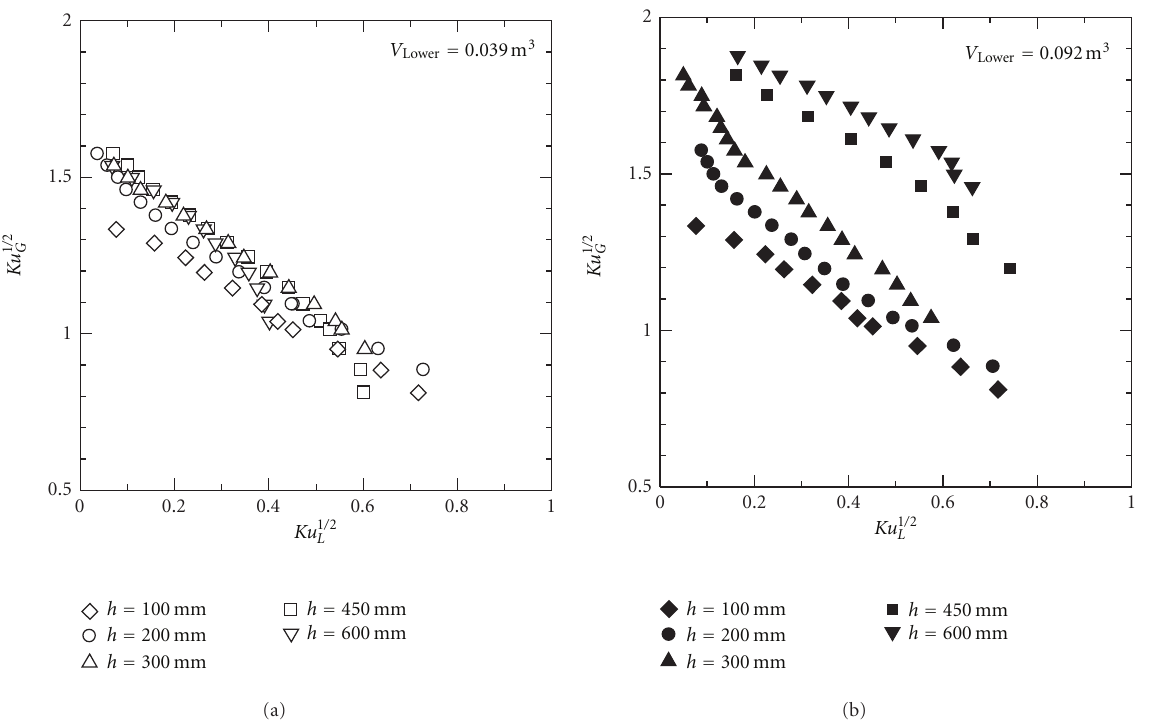
Figure 11: E ff ects of water level, h , in upper tank on CCFL characteristics ( D = 30 mm).